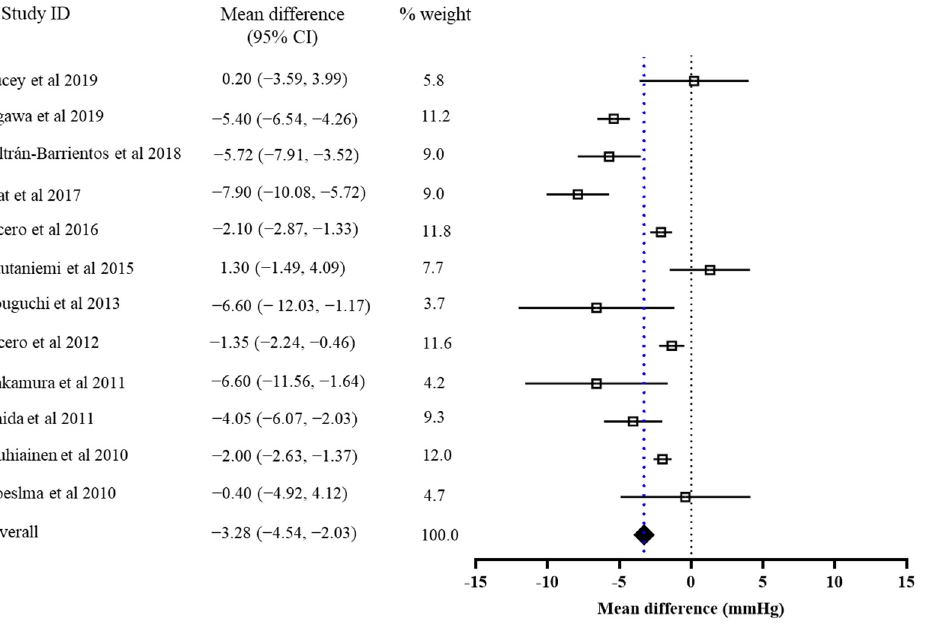
Figure 2. Overall change in SBP (mmHg) after peptide intervention.